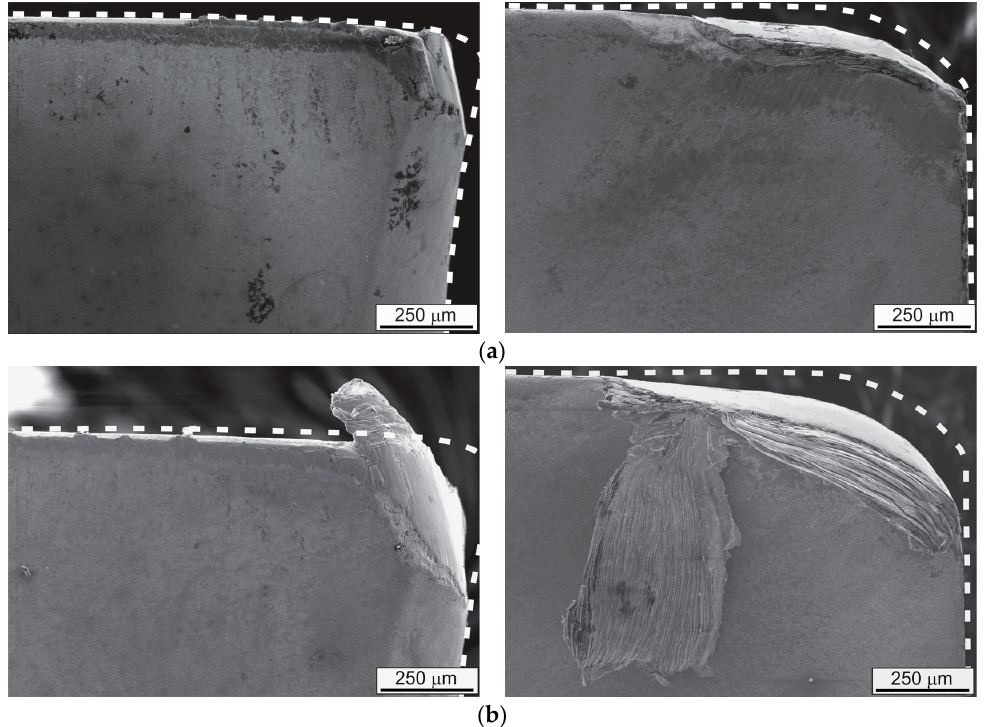
Figure 4. Scanning electron microscope (SEM) images of Tool dry1 bottom flank face on the left and rake face on the right, with zero pass edge outline (ZPEO): ( a ) after the third pass, and ( b ) after the fourth pass.